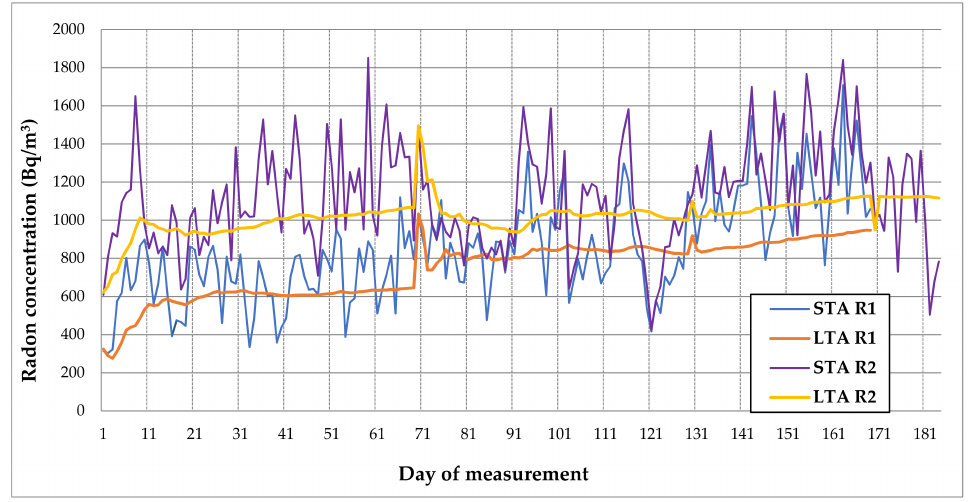
Figure 1. Short term average (STA) and longterm average (LTA) radon concentrations in living room (R1) and bedroom (R2).